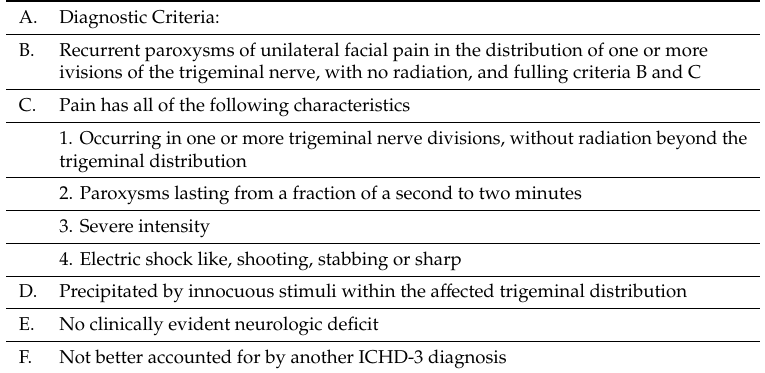
Table 1. The ICHD-3 criteria for the diagnosis of trigeminal neuralgia (ICHD, Cephalalgia 2013,